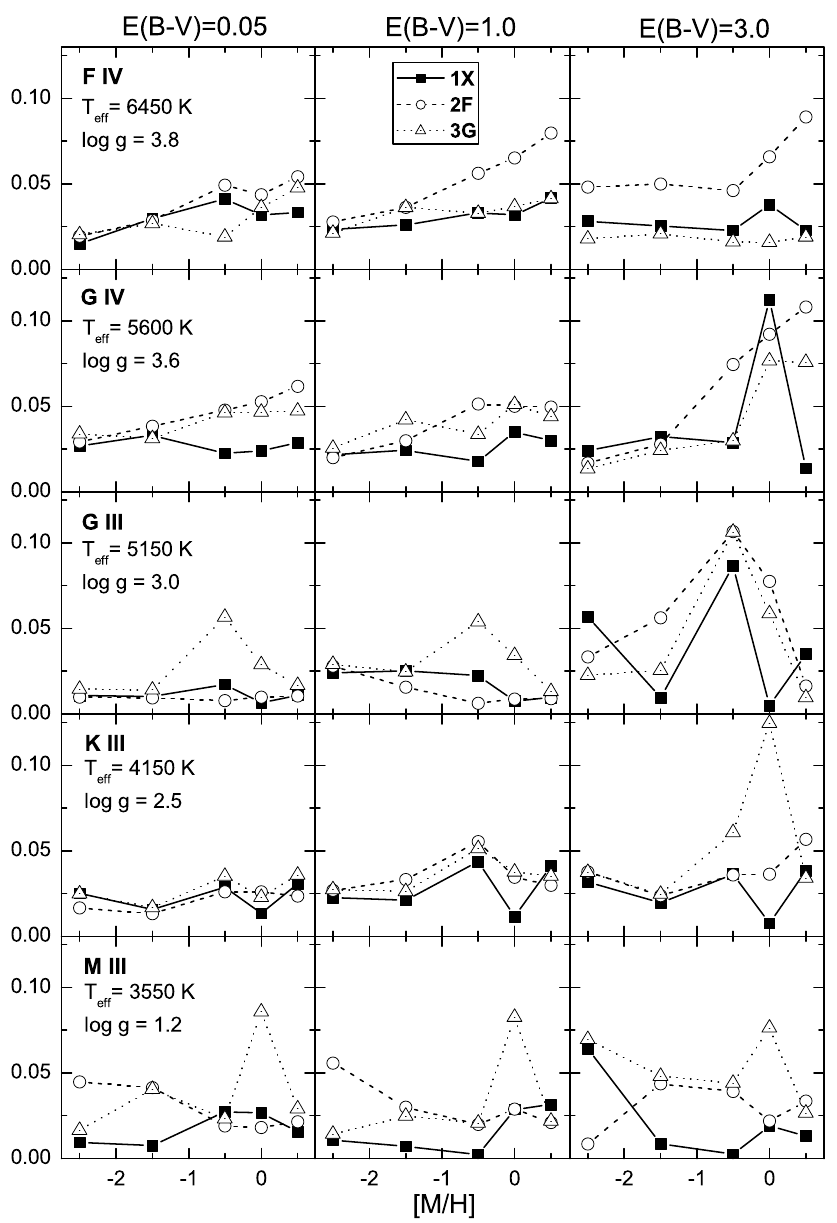
Fig. 2. Accuracy (r.m.s.) of E B − V determination vs. metallicity for the subgiant and giant stars at three different color excesses. Photo- metric systems are marked by: 1X – filled squares; 2F – open circles; 3G –